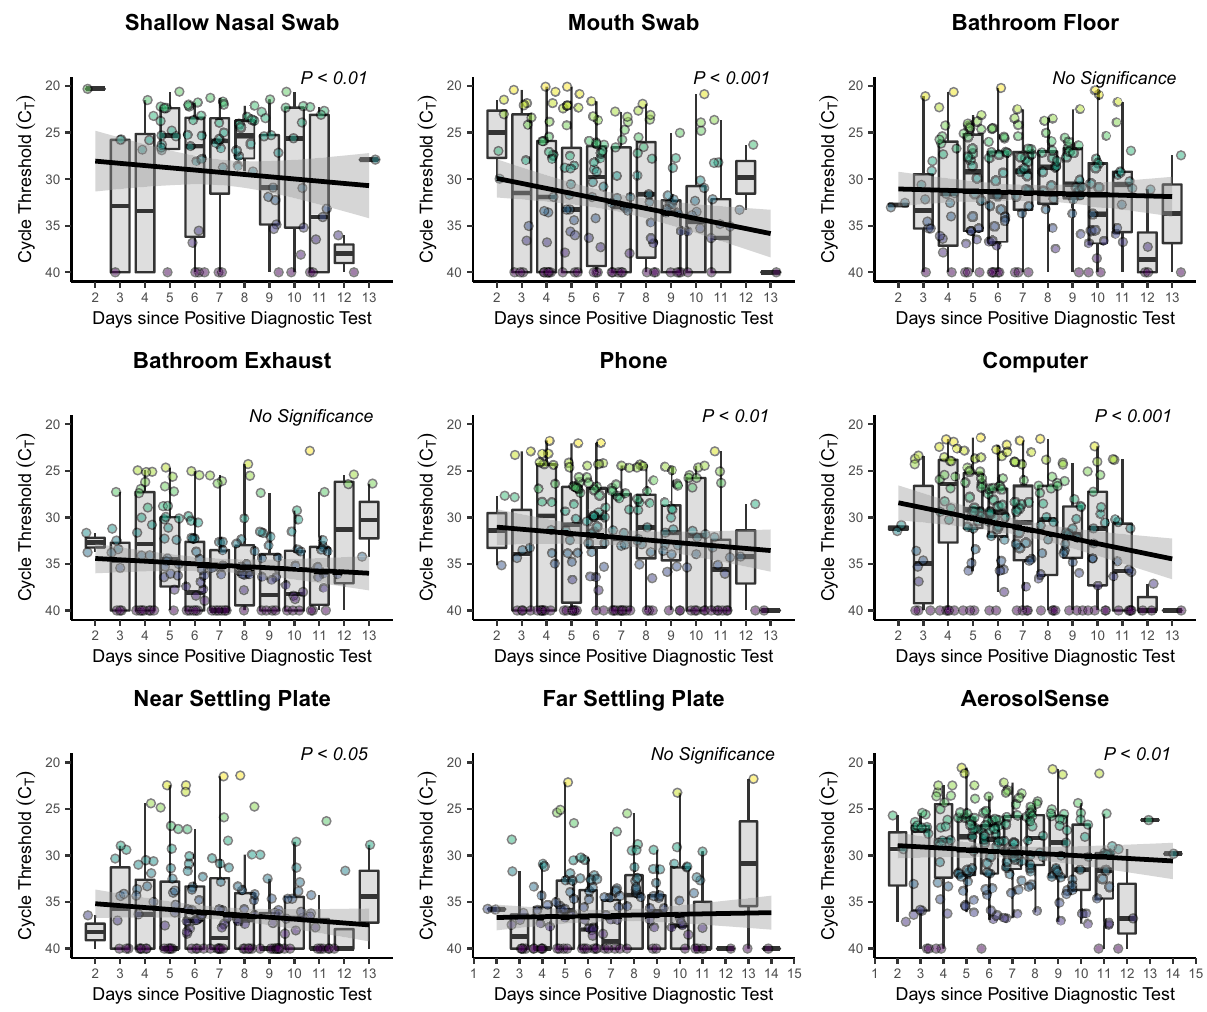
Figure 1. Longitudinal viral shedding and environmental contamination dynamics. The mean daily cycle threshold (C T ) for each sampling location throughout the course of the participants’ involvement in the study. Individual points represent the mean daily C T value per individual and are colored according to C T value with lighter colors representing lower C T values and darker colors representing higher C T values. The y-axis is inverted so that lower C T values are higher (to represent higher viral load) and higher C T values are lower (to represent lower viral load). The black line represents a linear mixed model estimated using a restricted maximum likelihood (REML) approach and including the individual occupying the room as a random effect and the grey area represents the 95% confidence interval for that